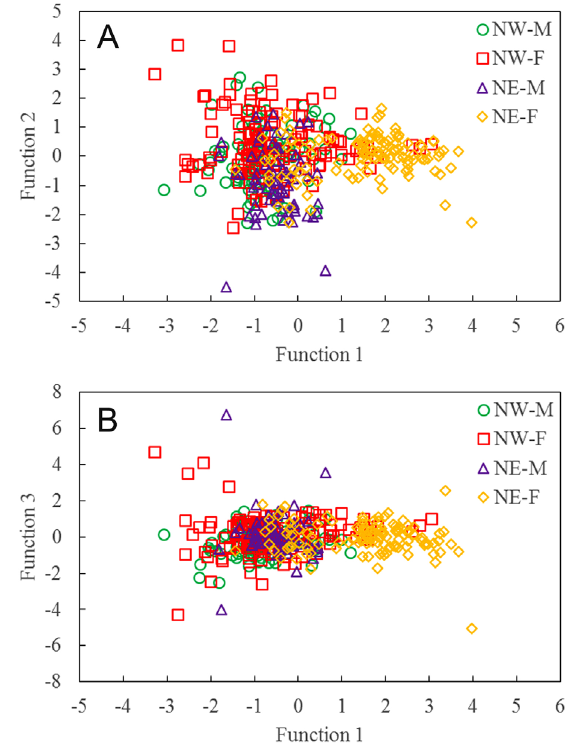
Fig. 3. – Canonical discriminant plots of standardized beak morpho- metric variables for samples in each sex from the two stocks in the North Pacific